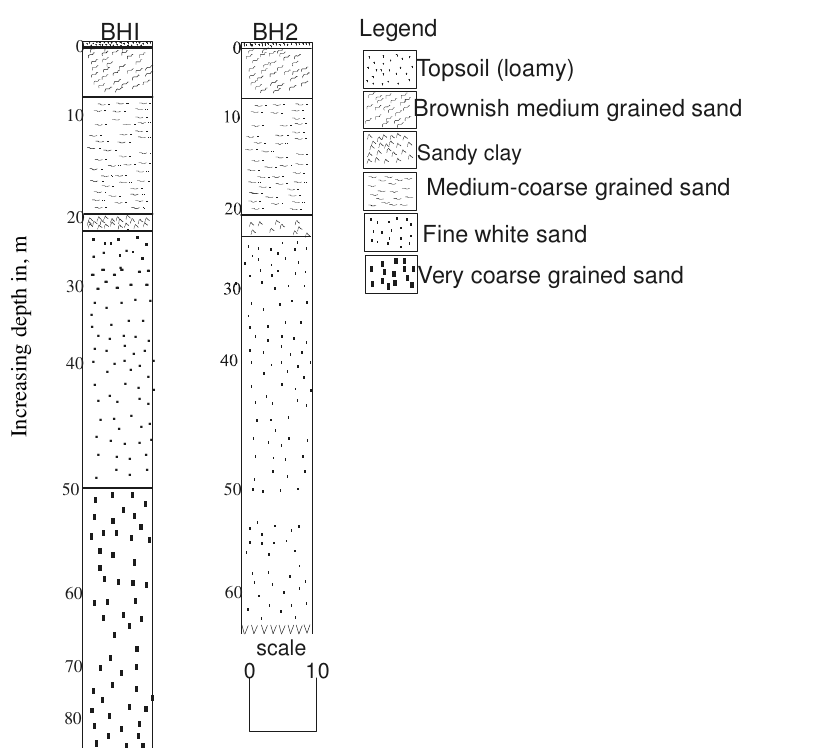
Figure 4 . Borehole lithology logs from the study